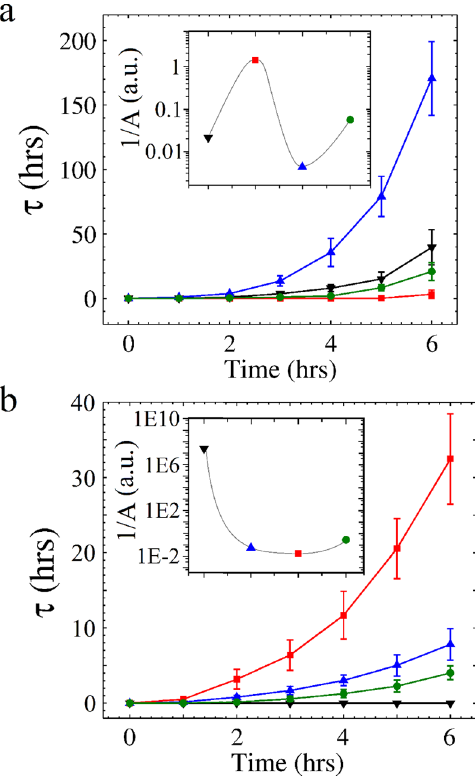
Figure 2. Sperm motility analysis: Temporal behavior of t . (a) Tetracaine-caffeine experiment (25 u C): Triangles down mark the control sample, squares mark 111 mM of caffeine, triangles up mark 8 mM of tetracaine, and circles mark the combination 8 mM of tetracaine- 111 mM of caffeine. (b) Tetracaine-calcium experiment (10 u C): Triangles down mark the control sample, triangles up 8 mM of tetracaine, squares 200 mM of CaCl 2 and circles the combination 8 mM of tetracaine-200 mM of CaCl 2 . Insets show the inverse of the area under curve ( A ) of each one of the temporal developments, highlighting the differences in overall motility.